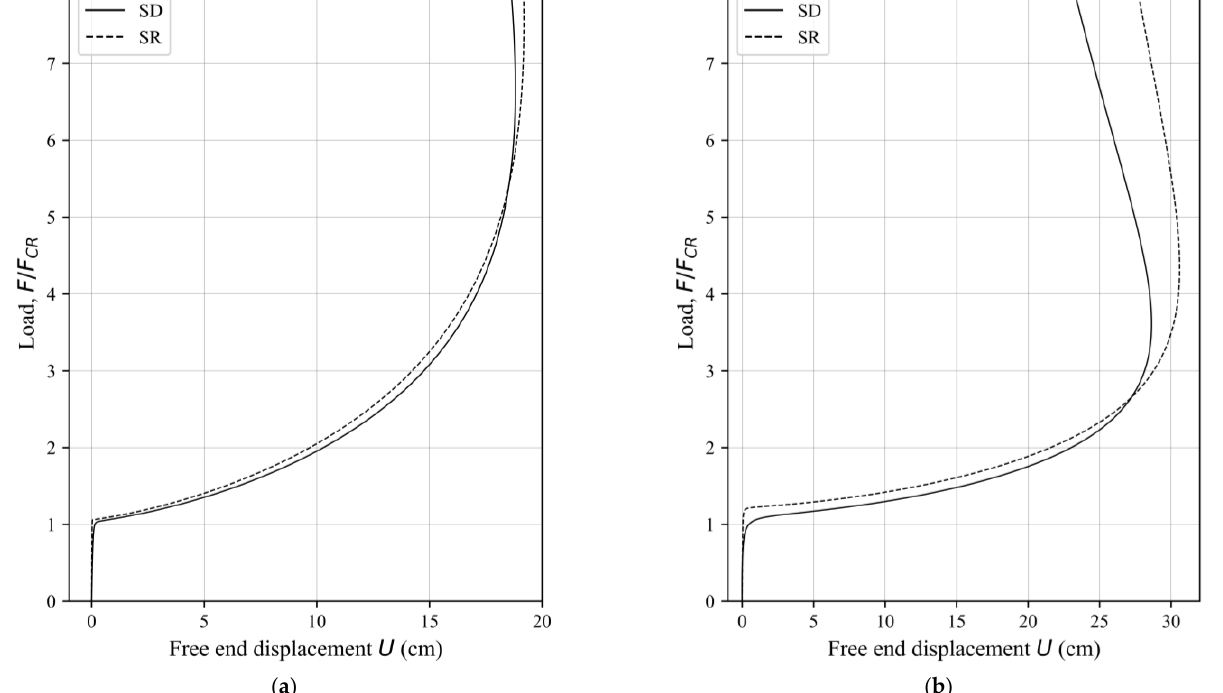
Figure 7. Buckling load vs. free end displacement in the X -direction: ( a ) + F and ( b ) − F .